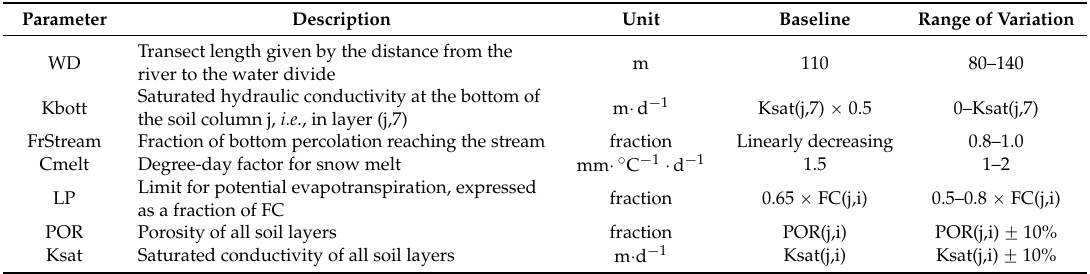
Table 1. Parameter ranges and baseline values used in the sensitivity